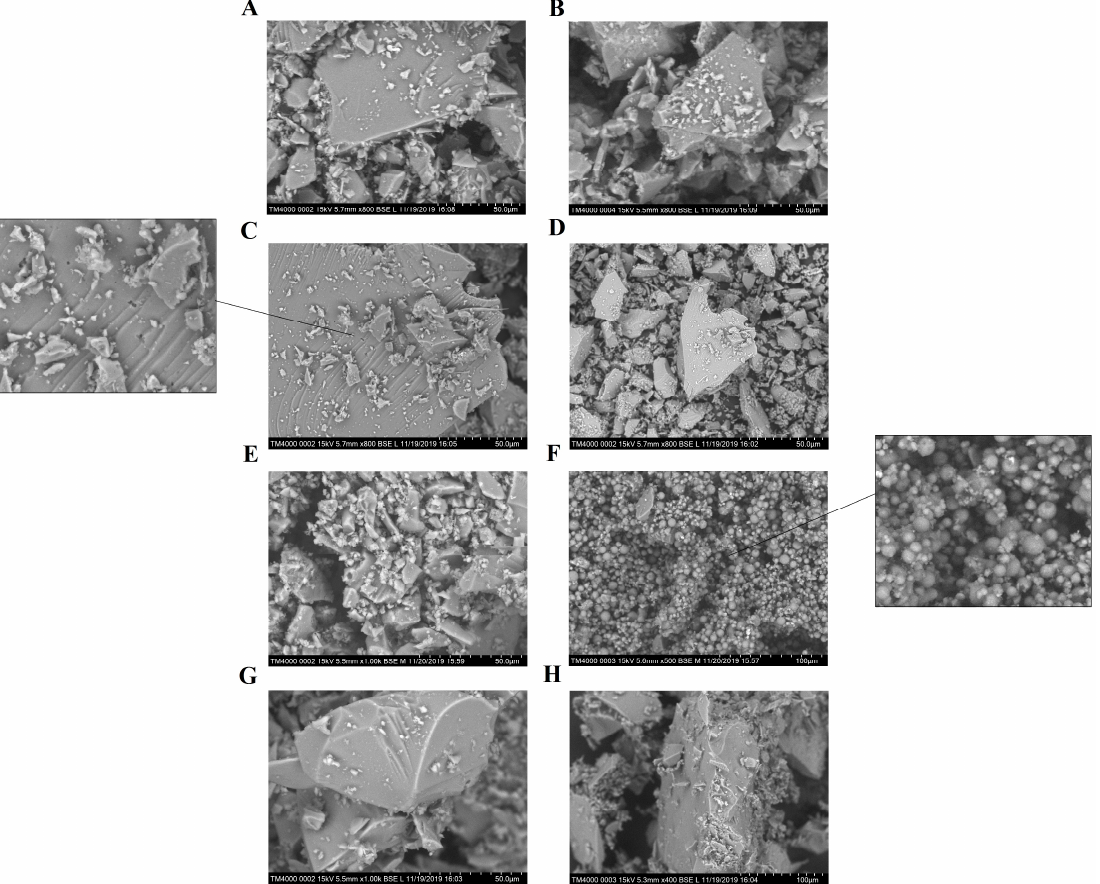
Figure 9. SEM images of the composites: ( A ) LA-UMS (pH 3), ( B ) LA-UMS (pH 7), ( C ) LA-MMS (pH 3), ( D ) LA-MMS (pH 7), ( E ) LA-APMS (pH 3), ( F ) LA-APMS (pH 7), ( G ) LA-MPMS (pH 3) and ( H ) LA-MPMS (pH 7).